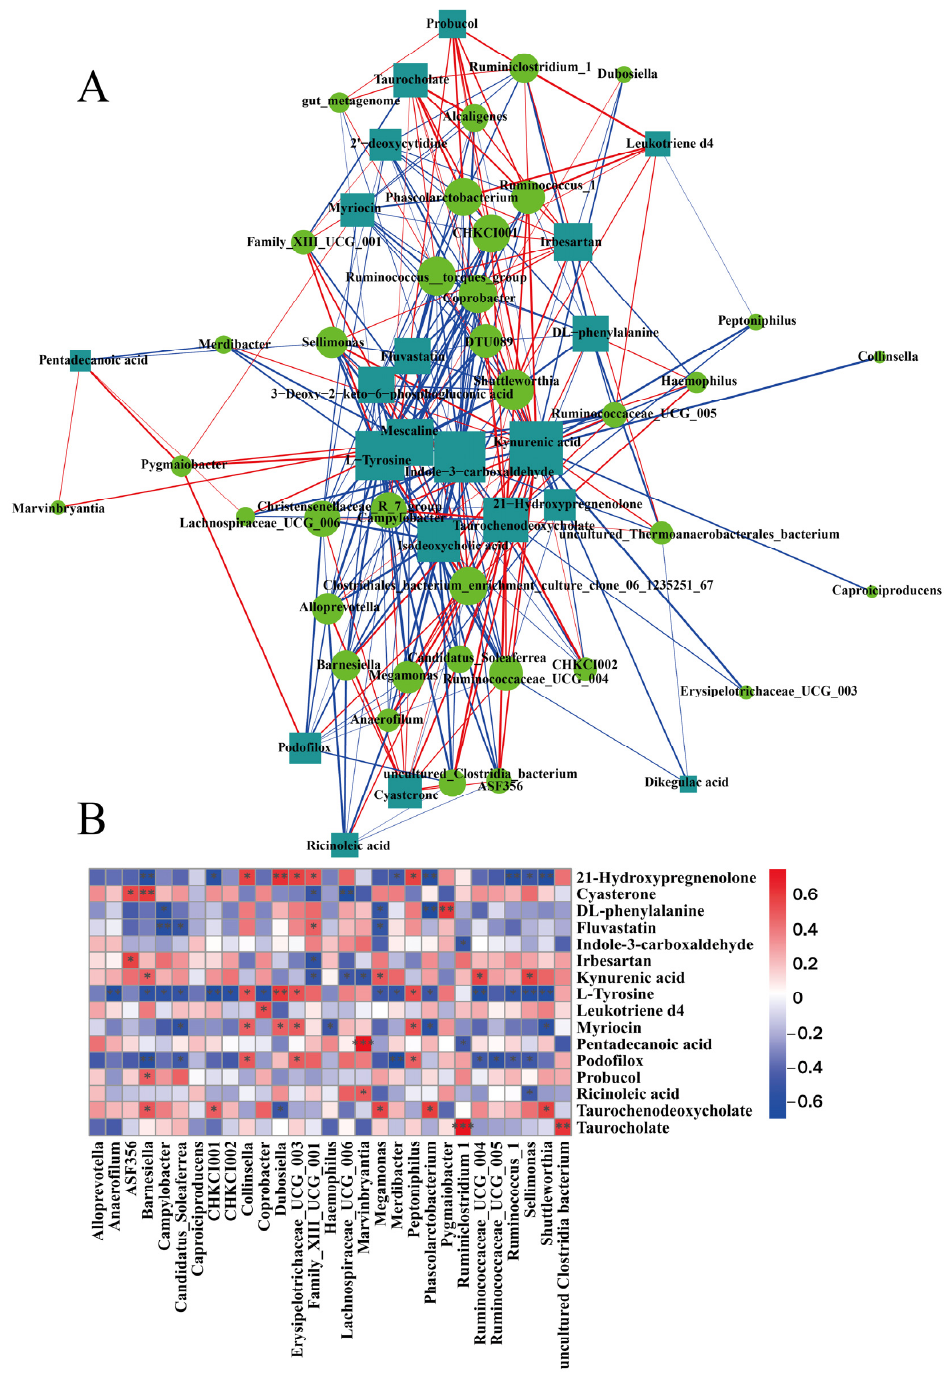
Figure 6. ( A ) Network diagram of Spearman’s correlation analyses for significantly different flora and significantly different metabolites. Genera with different significance levels are indicated by circles, and metabolites with different significance levels are shown by rectangles. The correlation between the two is denoted by the color of the line in the graph, with blue for negative correlation and red for positive correlation, and the line thickness is in proportion to the absolute value of the correlation coe ffi cient. ( B ) Hierarchical cluster heatmap for Spearman correlation analysis of di ff er- entially signi fi cant fl ora (LEfSe LDA > 2 and p < 0.05) and di ff erentially signi fi cant metabolites ( VIP > 1 and p < 0.05). * p < 0.05, ** p < 0.01, *** p < 0.001. VIP : variable importance in the projection.